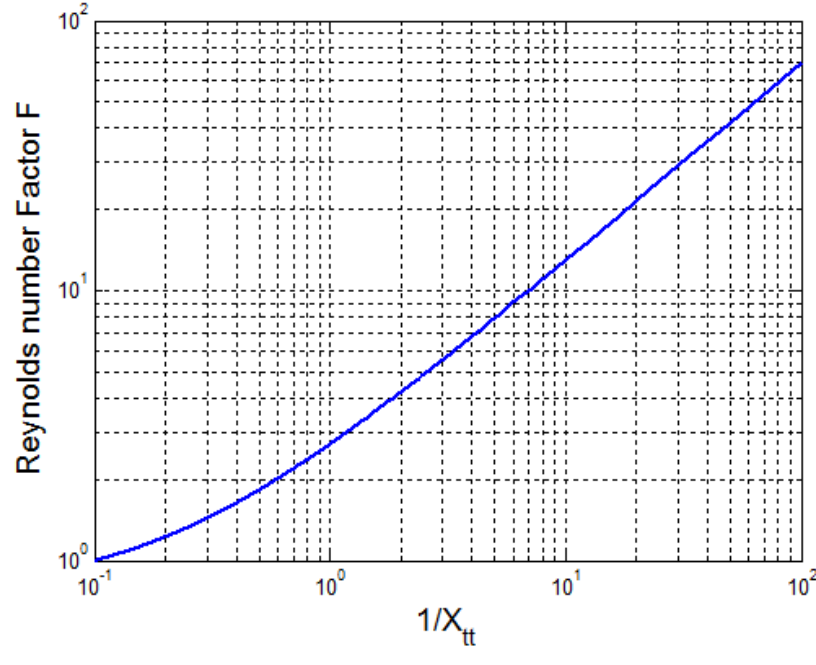
F ). Figure 5. Reynolds number factor ( F c c